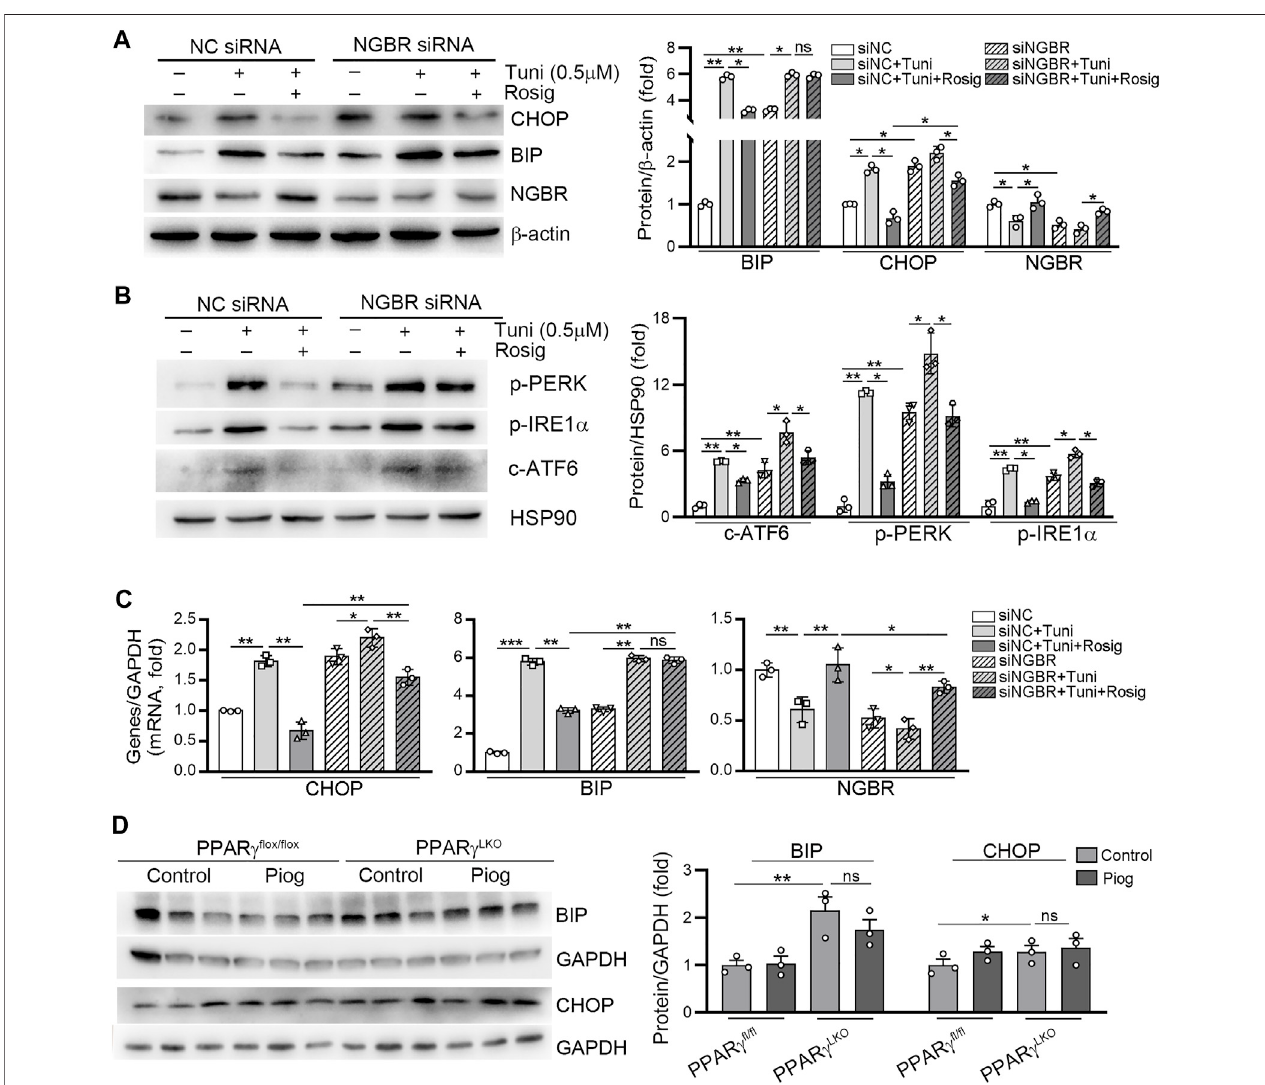
FIGURE 6 | PPAR γ reduces tunicamycin-induced ER stress by regulating NGBR. (A – C) HUVEC cells in a six-well plate were transfected with control siRNA (NC siRNA) or NGBR siRNA for 24 h in serum-free medium, followed by switching the cells into complete medium to culture for another 24 h. After treatment with rosiglitazone (10 μ M) for 12 h, the cells were treated with tunicamycin (0.5 μ g/ml) with or without rosiglitazone for another 12 h. Expression of CHOP, BIP, NGBR p-PERK, p-IRE1 α and c-ATF6 protein was determined by Western blot (A, B) . Expression of CHOP, BIP and NGBR mRNA was determined by qPCR (C) . Values were expressed as means ± SD. * p < 0.05; ** p < 0.01; ns, not signi fi cant ( n (cid:1) 3). (D) liver total proteins were collected from Figure 4 . Expression of BIP and CHOP in mouse liver was determined by Western blot. Values were expressed as means ± SD. * p < 0.05; ** p < 0.01; ns, not signi fi cant ( n (cid:1)